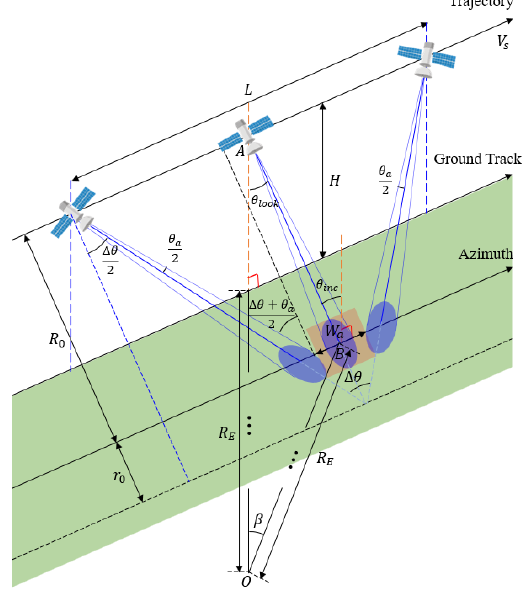
Figure 5. Illuminated geometry of broadside sliding spotlight SAR.